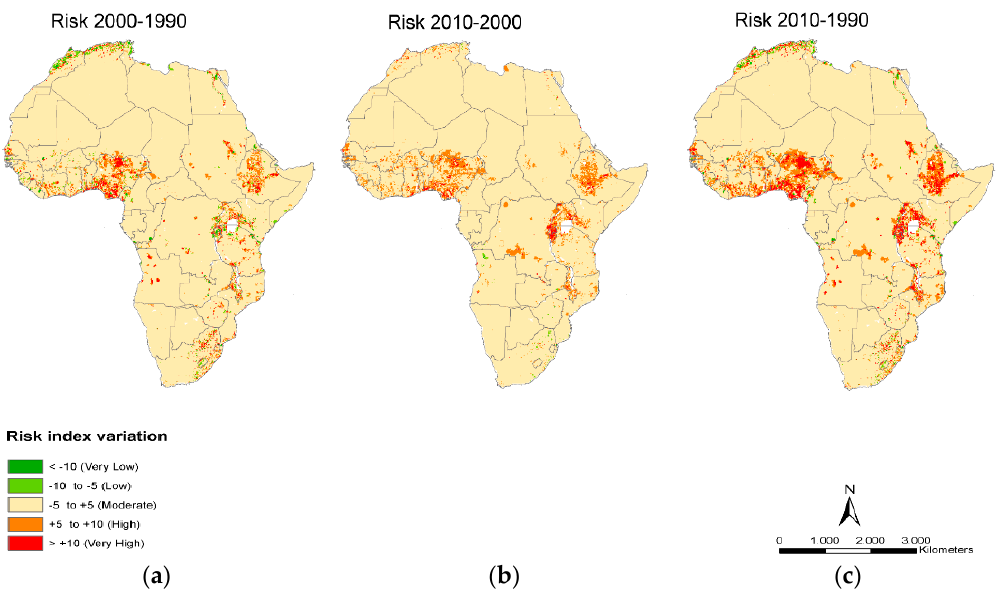
Figure 7. Difference of groundwater vulnerability between ( a ) 2000 and 1990, ( b ) 2010 and 2000, and ( c ) 2010 and 1990 for the African continent.